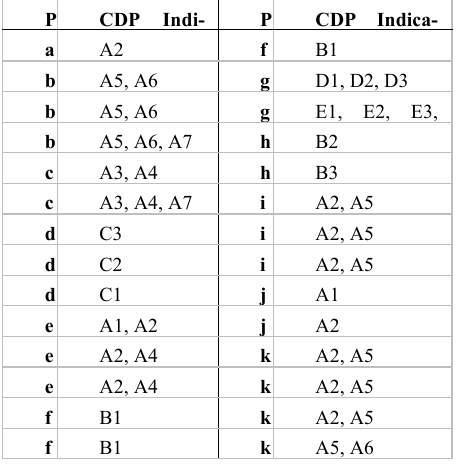
Table 6. Mapping among CDP evaluation criteria and